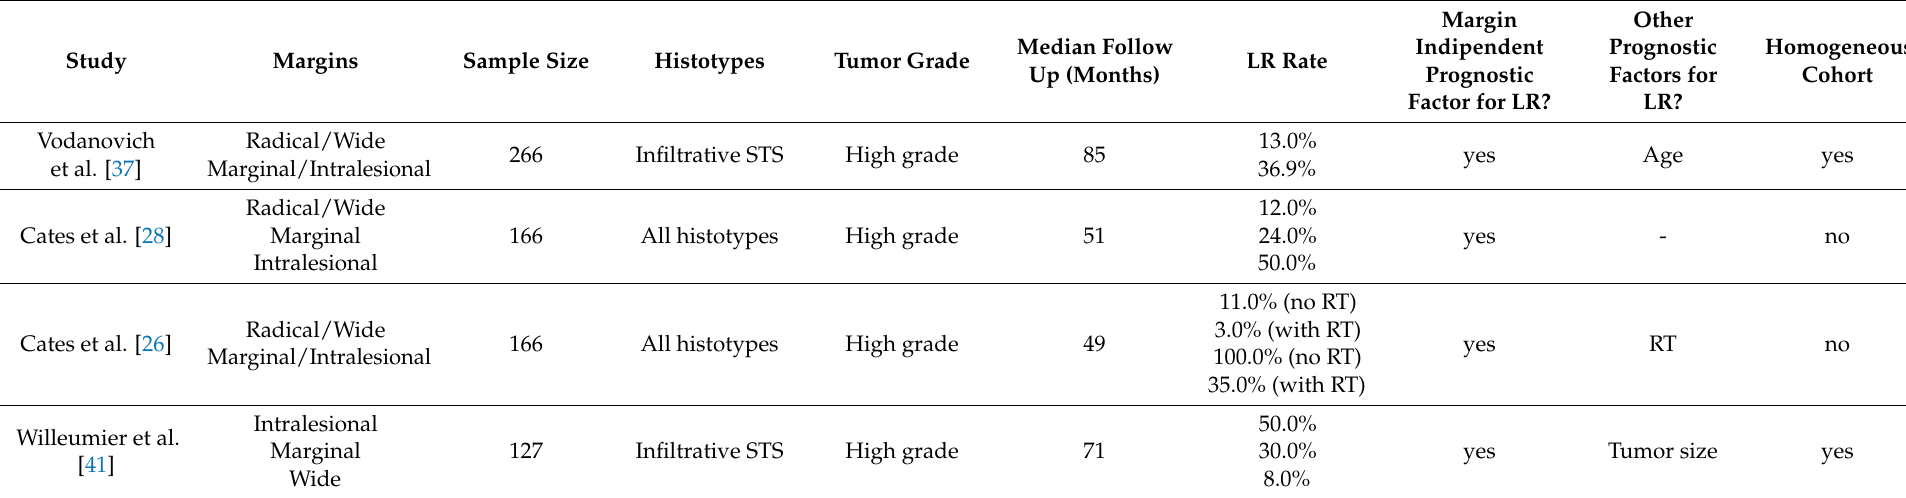
Table 2. Review of the literature. Studies reporting margins based on MSTS classification.